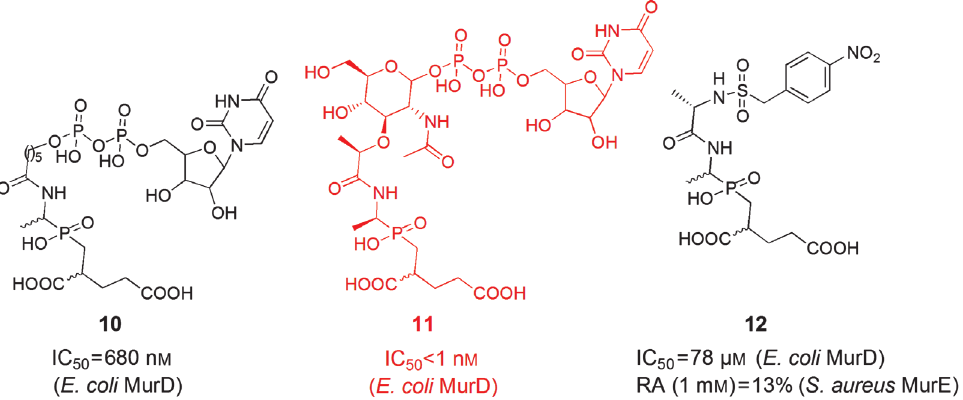
α -carboxyl group is held in position through interactions with Thr321 and Lys348 directly. In the MurD/ 21 complex (PDB entry: 2Y1O), the α -carboxyl group interacts with Lys115 and Lys348 via water molecules (Figure 3B), which is a unique property of the binding mode of inhibitor 21 (93). No polar contacts between the protein and the central linker part of the inhibitors exist. Here, only π - π stacking of the aminophenyl ring with Phe161 and hydro- phobic interactions of the benzylidene ring with Gly73 are worth